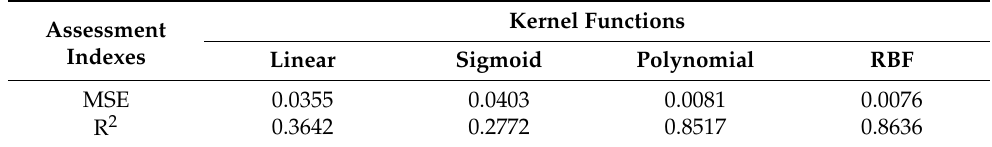
Figure 13. Prediction of SVR with different kernel functions on X coordinate. ( a ) Linear kernel. ( b ) Sigmoid kernel. ( c ) Polynomial kernel. ( d ) RBF kernel. Table 5. Model performance with different kernel functions.